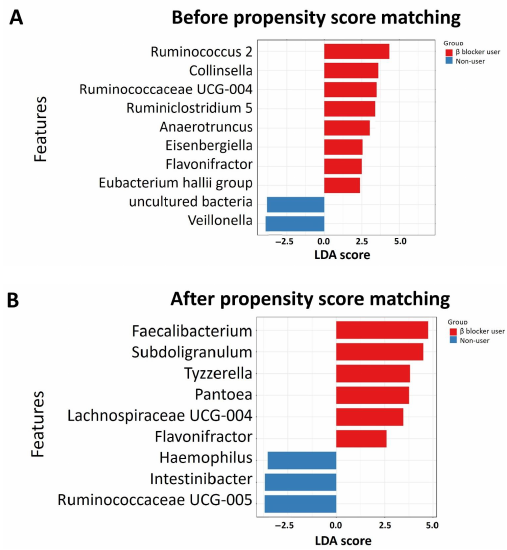
Figure 3 Figure 3. Taxonomic differences were detected between β blocker users and nonusers in the full cohort ( A ) and propensity score matching cohort ( B ). Linear discriminative analysis (LDA) effect size (LEfSe) analysis between β blocker users (red) and nonusers (blue) with an LDA score > 2.0 or < − 2 with p -value > 0.1 among β blocker users and nonusers.